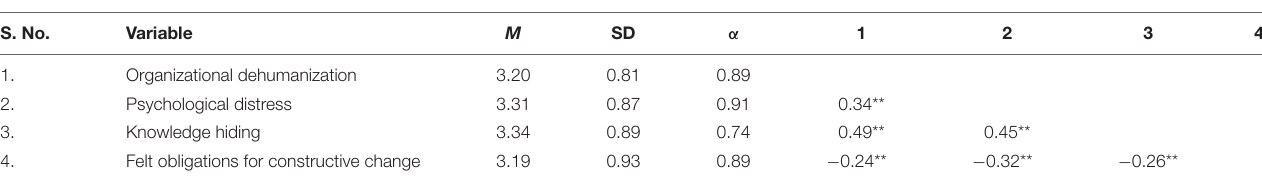
TABLE 2 | Mean, standard deviation, reliability, and correlation. S. No.